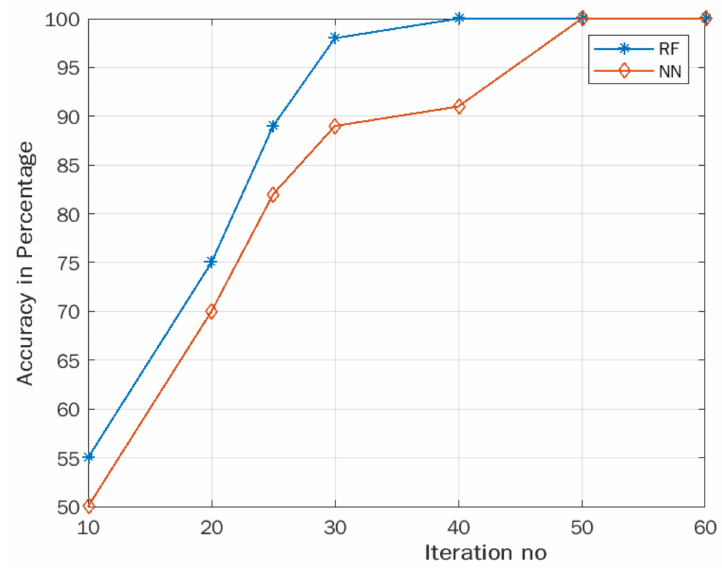
Figure 10. Accuracy vs. iteration number.